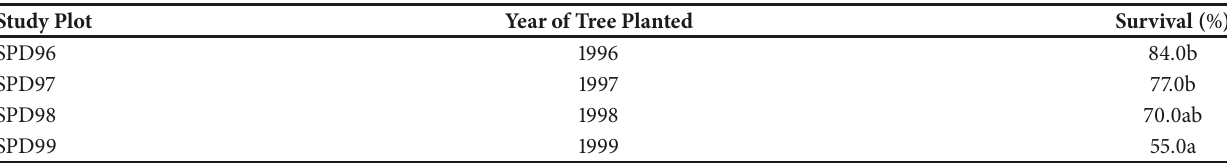
Figure 2: Planting design within reforestation sites showing the main plots (six random replications in each main plot), planting distance, and planting direction. Table 1: Survival of planted S. macrophylla in plot aged 20 years (SPD96), plot aged 19 years (SPD97), plot aged 18 years (SPD98), and plot aged 17 years